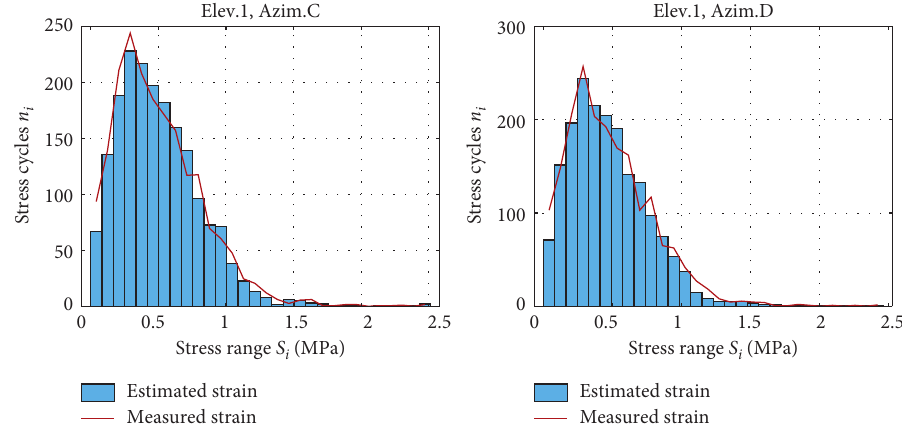
Figure 8: Stress histogram for dataset 14.